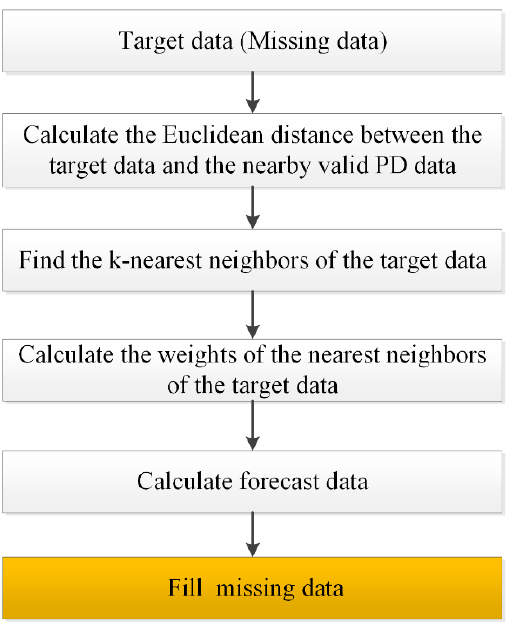
Figure 3. The basic flow of the algorithm.